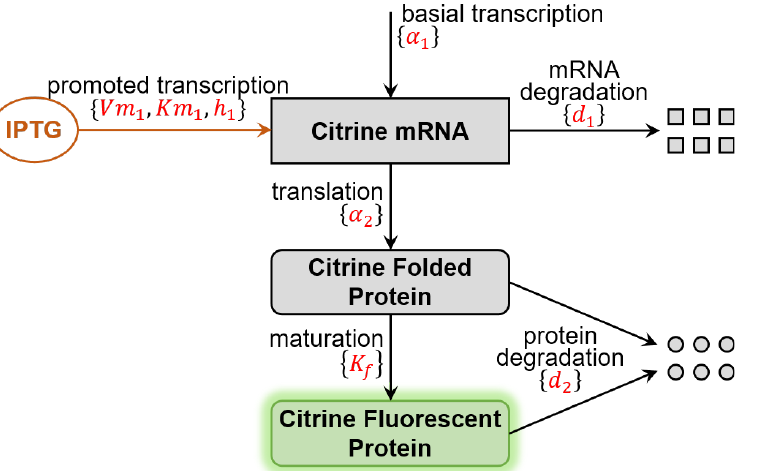
Figure 2. Illustration of the reactions considered in the model and how the parameters describes the